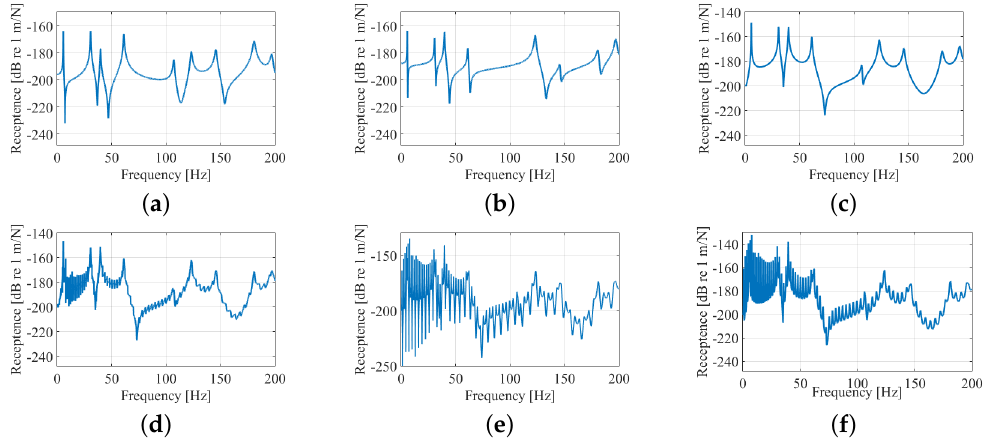
Figure 14. FRFs of the OTL obtained due to a unitary excitation force imposed at point ‘ a ’ (red dot) and results: ( a , b ) tower, ( c ) tower-cable connection, ( d ) Cable 1 m from the support, ( e ) middle of the cable, ( f ) end of the cable